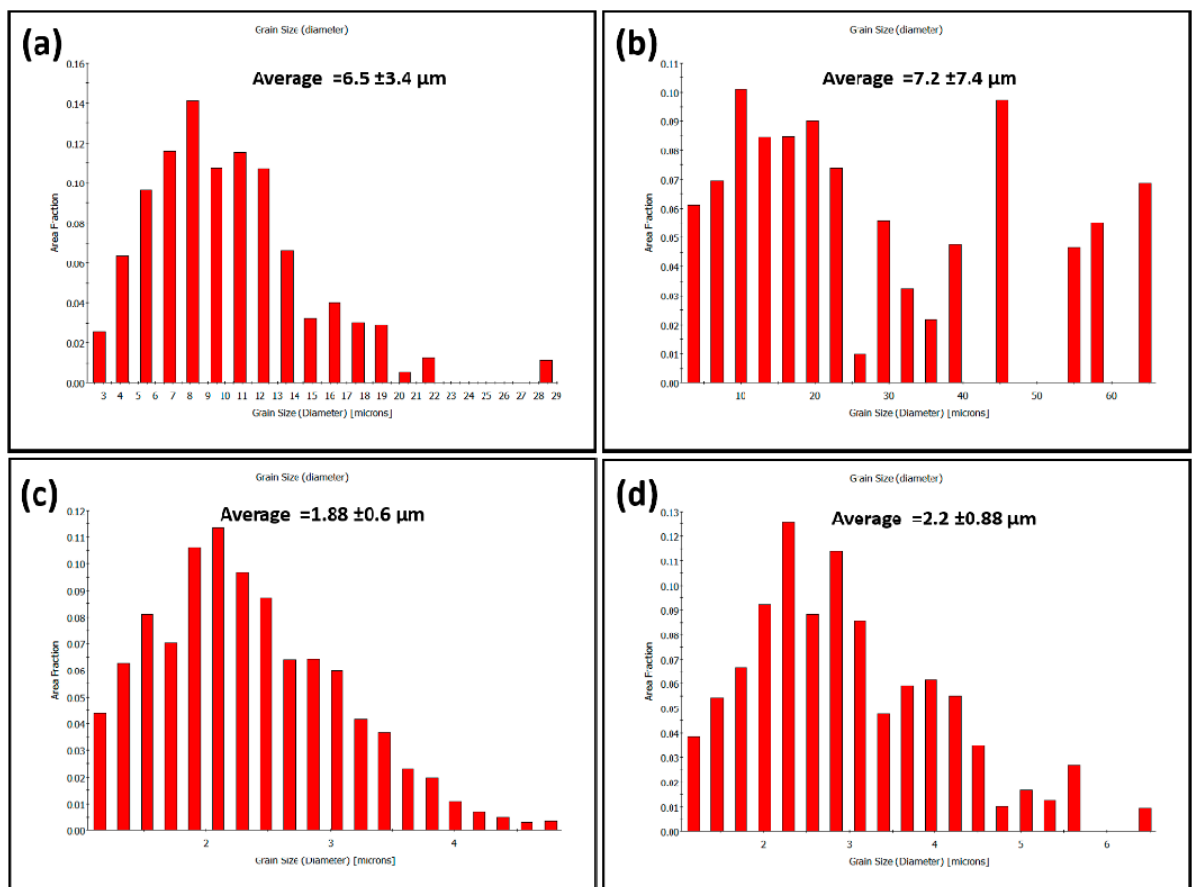
Figure 14. Grain size distribution of BM ( a ) austenite, ( b ) ferrite and NG of FSWed joint ( c ) austenite, ( d )